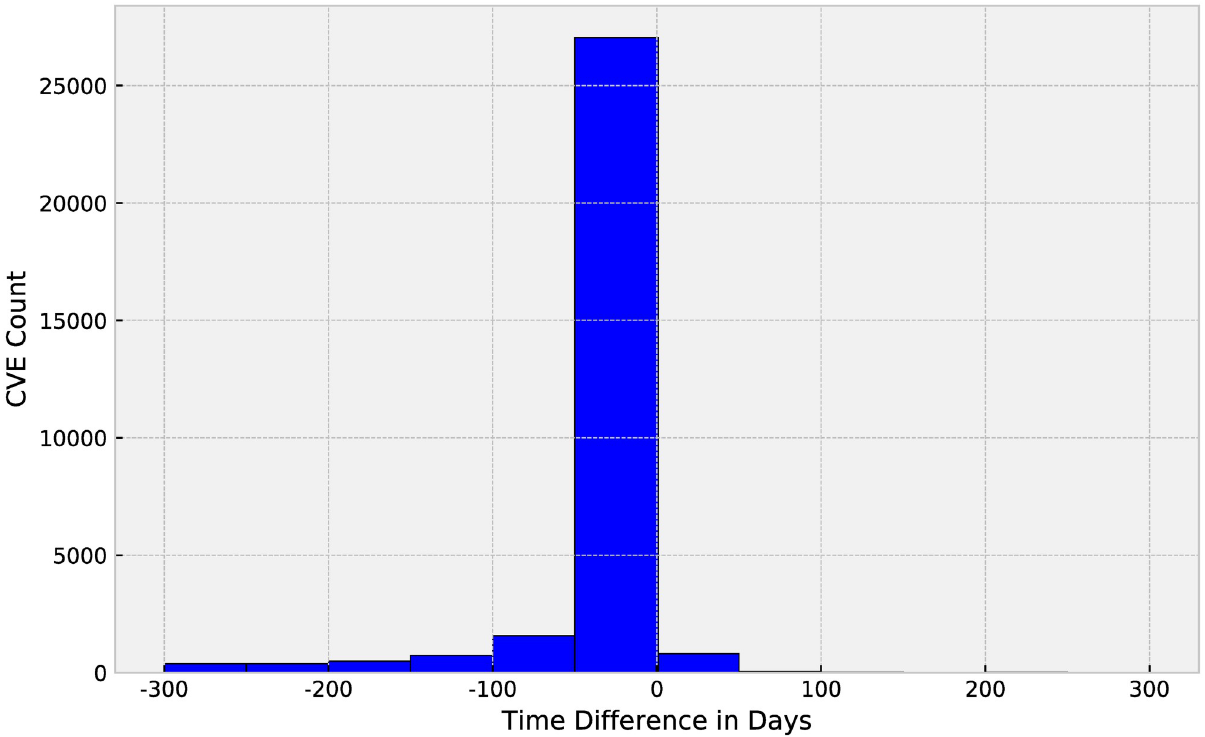
Fig 3. Distribution of the difference in days between vulnerability disclosure of NVD and